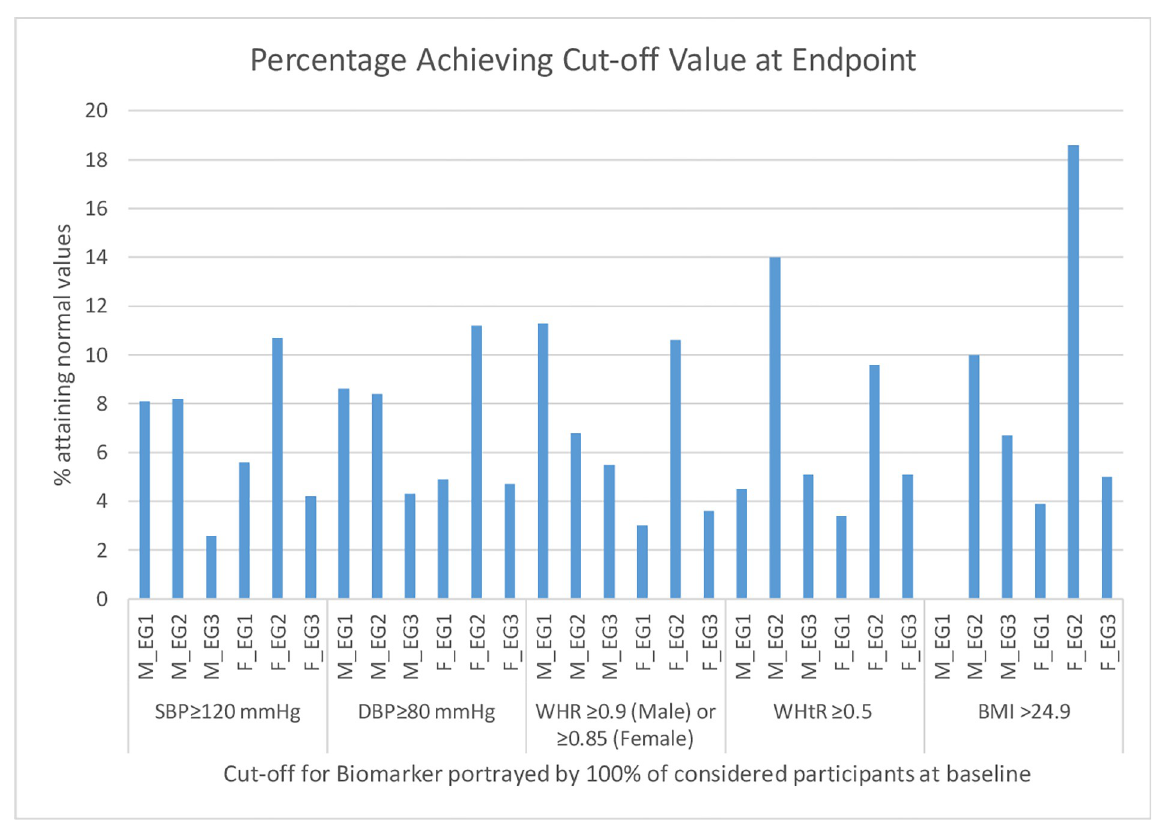
Fig 2. Percentage attaining recommended cut-offs after 12